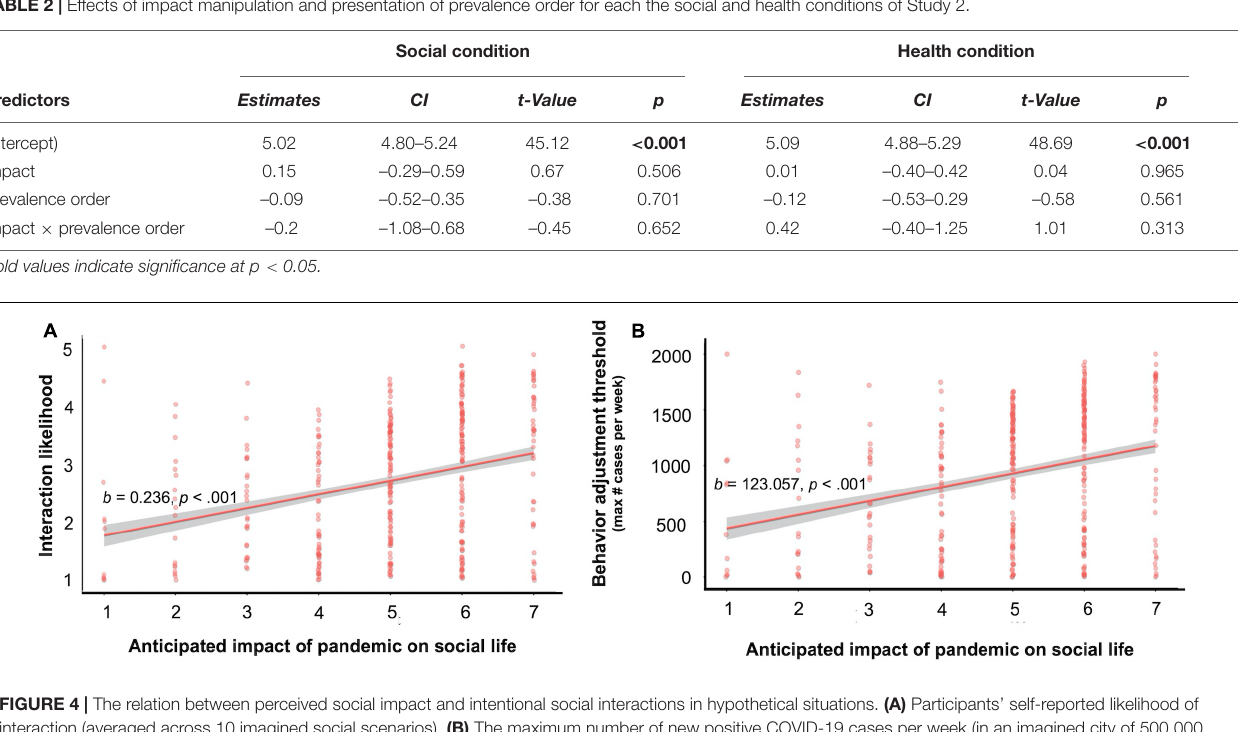
TABLE 2 | Effects of impact manipulation and presentation of prevalence order for each the social and health conditions of Study 2.